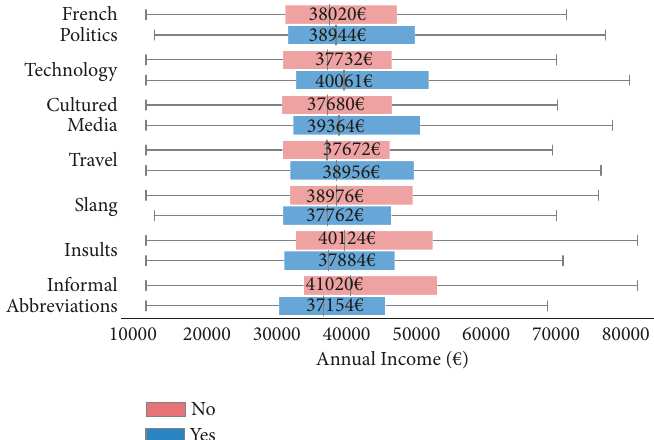
Figure 8: Average income for users who tweeted about a given topic (blue) vs. those who did not (red). Label of the considered topic is on the left. Table 2: Classification performance (5-CV): AUC scores (mean ± STD) of five different classifiers on each dataset. Census Occupation Expert AdaBoost 0.549 ± 0.009 Logistic Reg.